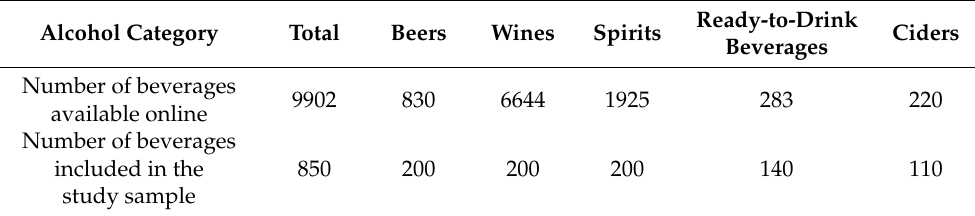
Table 1. Total number of beverages (by category) available online from the alcohol retailer (June 2021) and included in the study sample for the in-store audit (July